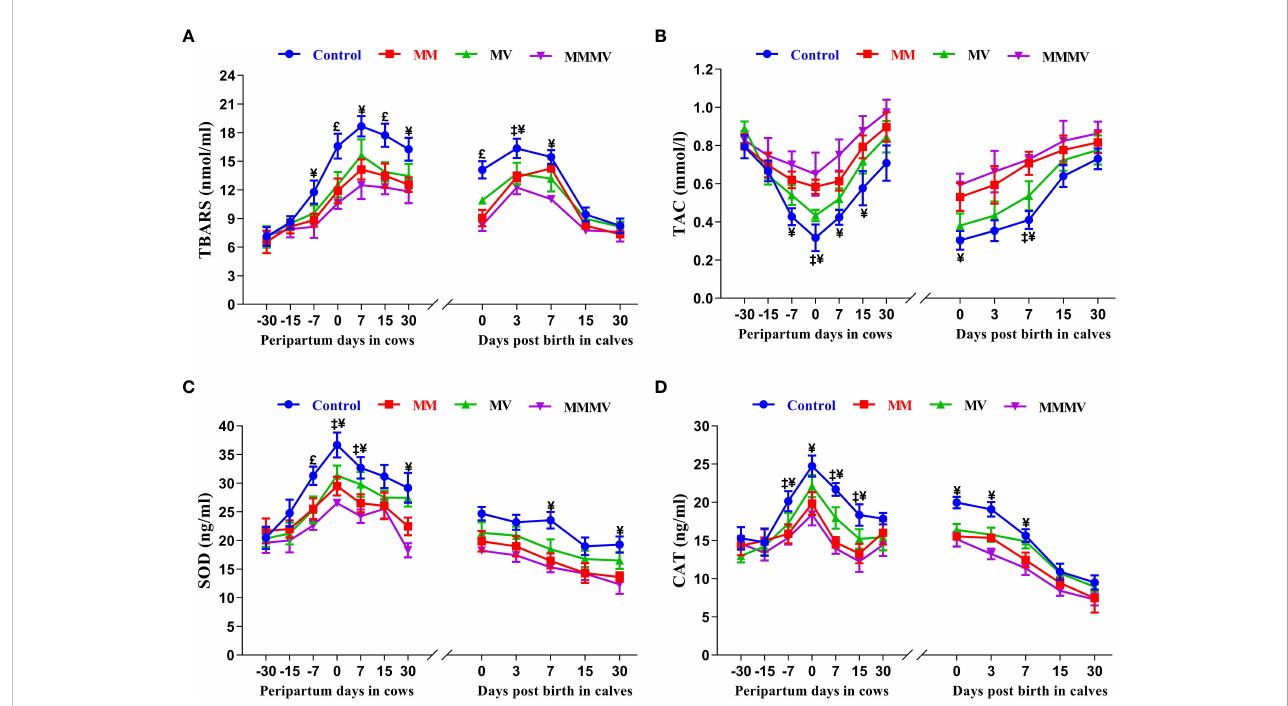
FIGURE 6 The blood plasma concentration of oxidative stress biomarkers including thiobarbituric acid reactive substances (TBARS, nmol/ml), total antioxidant capacity (TAC, mmol/l), superoxide dismutase (SOD, ng/ml), and catalase (CAT, ng/ml) in control and treatment groups of crossbred cattle and their calves ( A-D ), respectively. Control: received basal diet only, MM: basal diet + injectable multimineral, MV: basal diet + injectable multivitamins, MMMV: basal diet + combination of injectable multimineral and multivitamins. The mean values with different superscript symbols represent signi fi cant differences with the control group at different days of peripartum in cows and post birth in calves; ‡ Control Vs MM, † Control Vs MV, ¥ Control Vs MMMV. £ Control Vs MM, MV and